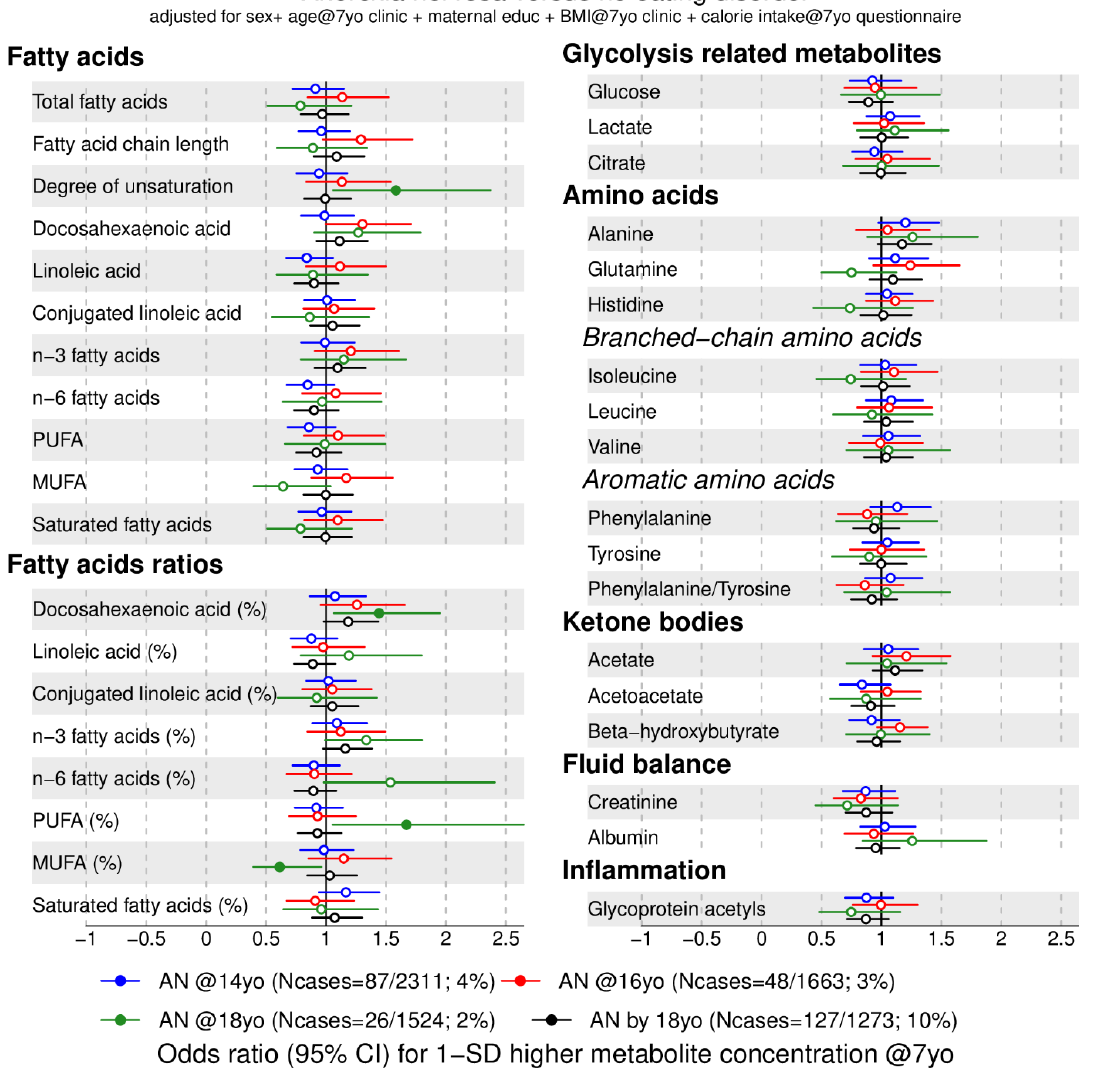
Figure 2. Estimated odds ratios for anorexia nervosa at 14, 16, 18 years of age and cumulatively across all three time points according to lipid- and non-lipid-related metabolic trait concentrations at 7 years (Figure 1 continued). Estimates refer to 1 standard deviation increase in metabolic trait concentration at 7 years. Error bars = 95% confidence intervals (CI). Abbreviations: AN = anorexia nervosa; MUFA = monounsaturated fatty acids; PUFA = polyunsaturated fatty acids. Note: Filled dot: CI do not include the null. MUFA, PUFA and saturated fatty acid concentrations include all fatty acids detected which have one, more than one, or zero C=C double bonds in their backbone, respectively.